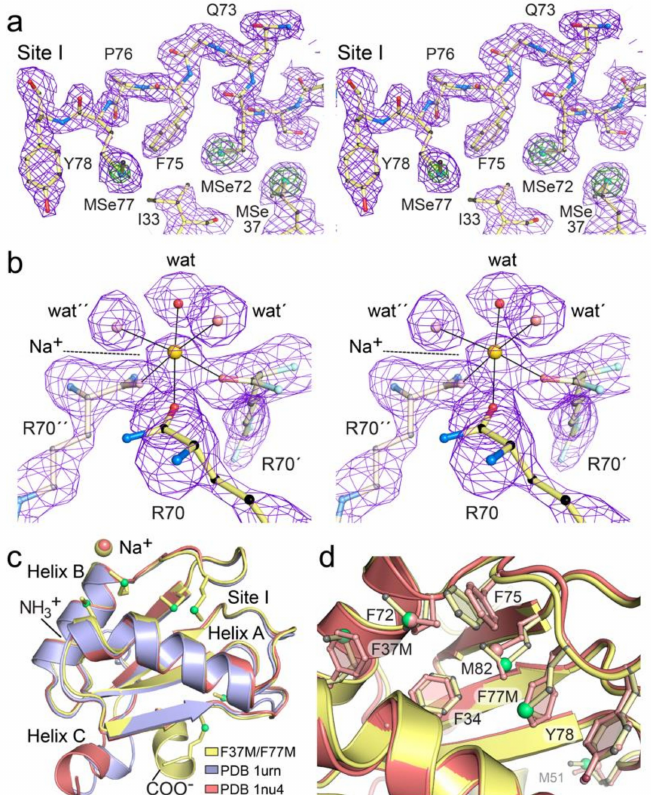
Figure 6. Representative electron density maps of the selenomethionine-labeled dmU1A(F37M/F77M) variant and comparison of dmU1A structures. ( a ) Stereo view of 2m F o − D F c electron density (purple) contoured at 1.0 σ (purple) and 5.0 σ (green) for the site I hydrophobic pocket. Amino acids including F37M and F77M are depicted as ball-and-stick models. ( b ) Stereo view of a simulated-annealing composite omit map depicting a sodium ion on the crystallographic 3-fold axis. The ion is coordinated by three carbonyl oxygens from R70 and three waters (labeled ‘wat’). For clarity, only the R70 amino acid, the Na + ion and an inner sphere water were omitted from the phase calculation; the amide nitrogen of S71 is shown to indicate the peptide bond but was included in the phase